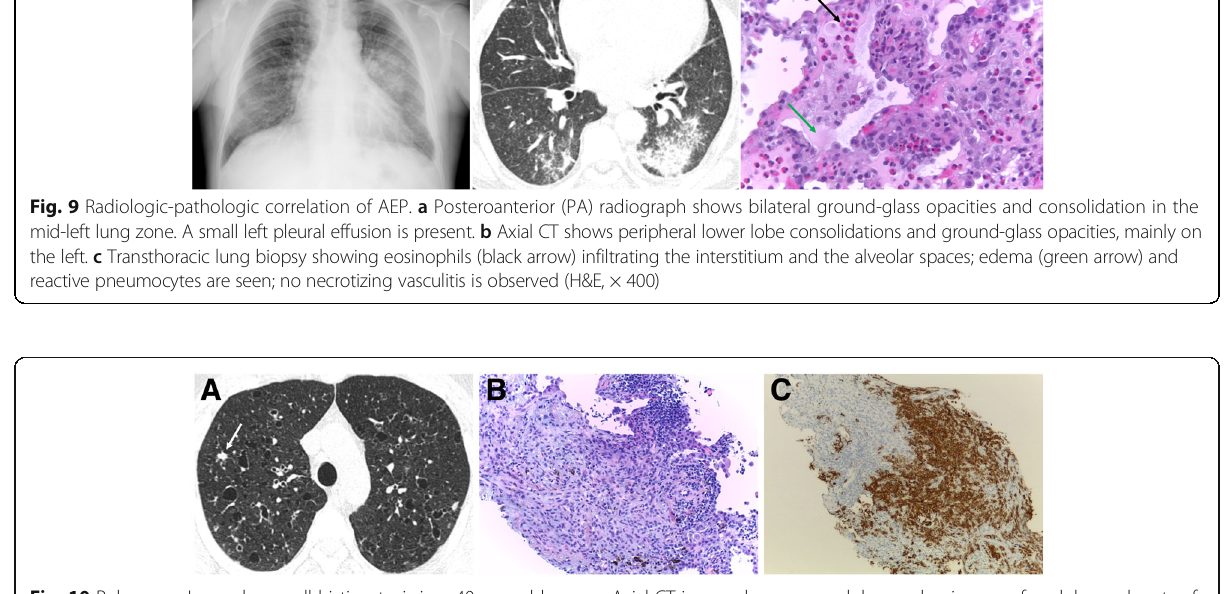
Fig. 10 Pulmonary Langerhans cell histiocytosis in a 40-year-old man. a Axial CT image shows upper lobe predominance of nodules and cysts of varying wall thickness and irregular margins. Arrow depicts a stellate cellular nodule. b Transthoracic lung biopsy of the nodule highlighted in a shows a nodular aggregate of cells (lymphocytes, eosinophils, plasma cells, and Langerhans cells) centered in bronchioles (arrow) and extending to the interstitium (H&E, × 200). c CD1a immunostaining highlights the Langerhans cells (CD1a, ×